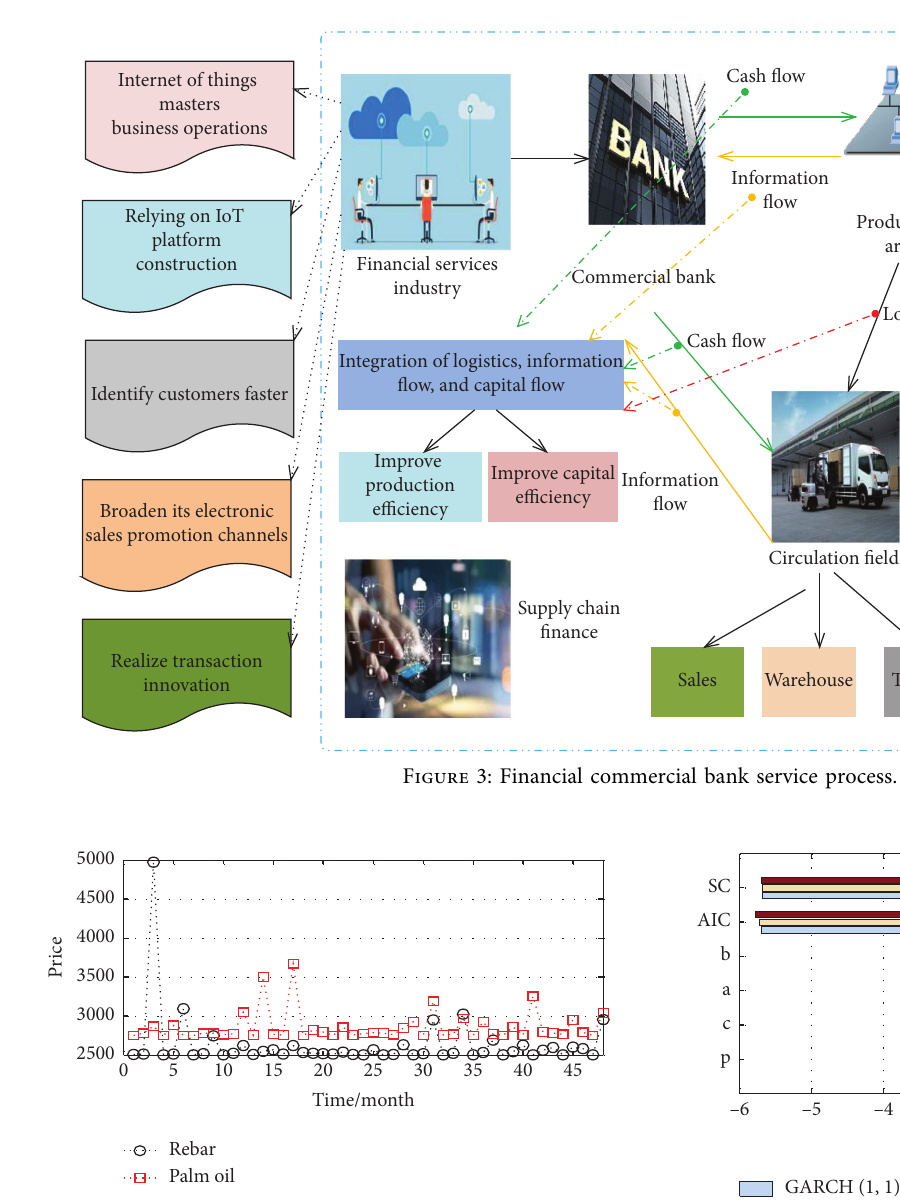
Figure 4: Trends of rebar median price and palm oil median price.